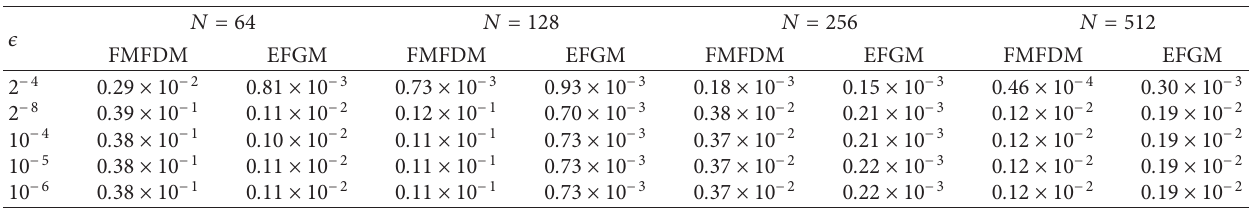
Table 4: Comparison of L errors for the fitted mesh finite-difference method (FMFDM) [39] and the EFG method for Example ∞